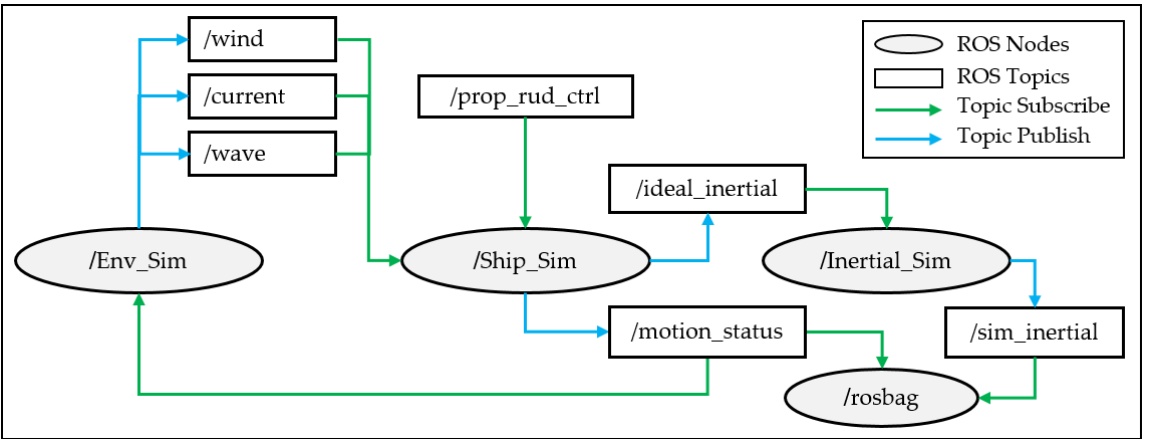
Figure 6. Simulation framework of shipborne inertial sensors.